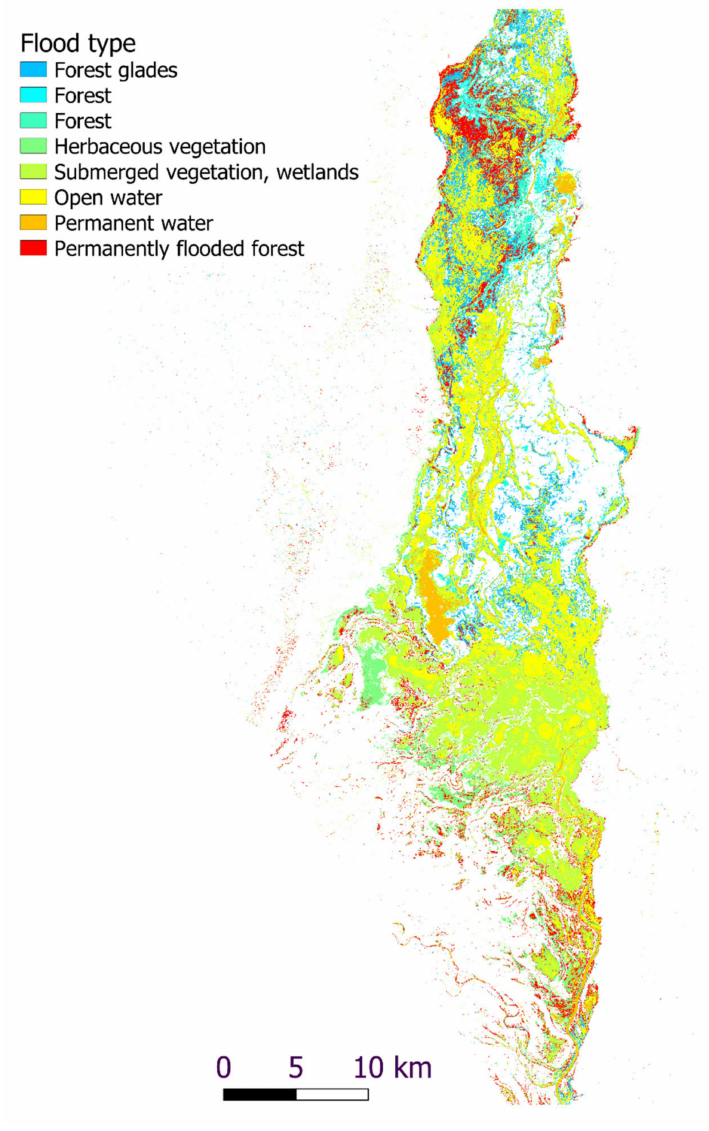
Figure 20. Flood map resulting from the integration of the multi-frequency information. Legend reports the interpretation of the cluster typologies, colored according to the scheme as in Figure